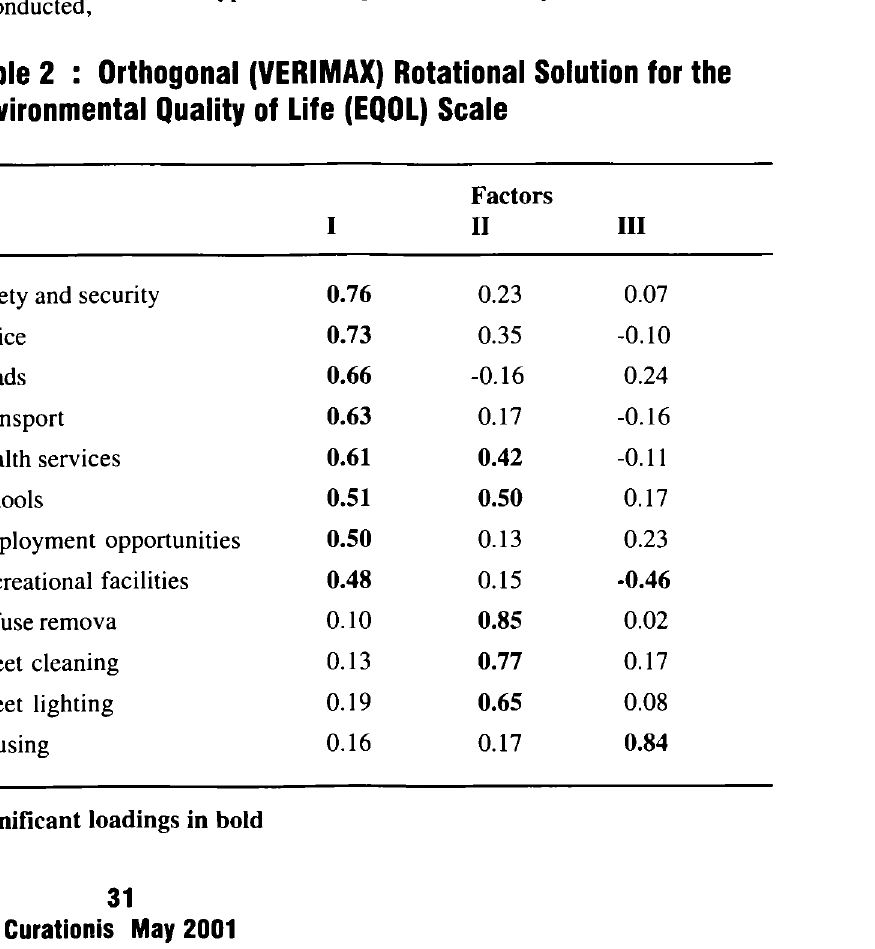
Table 2 : Orthogonal (VERIM AX) Rotational Solution for the Environmental Quality of Life (EQOL)